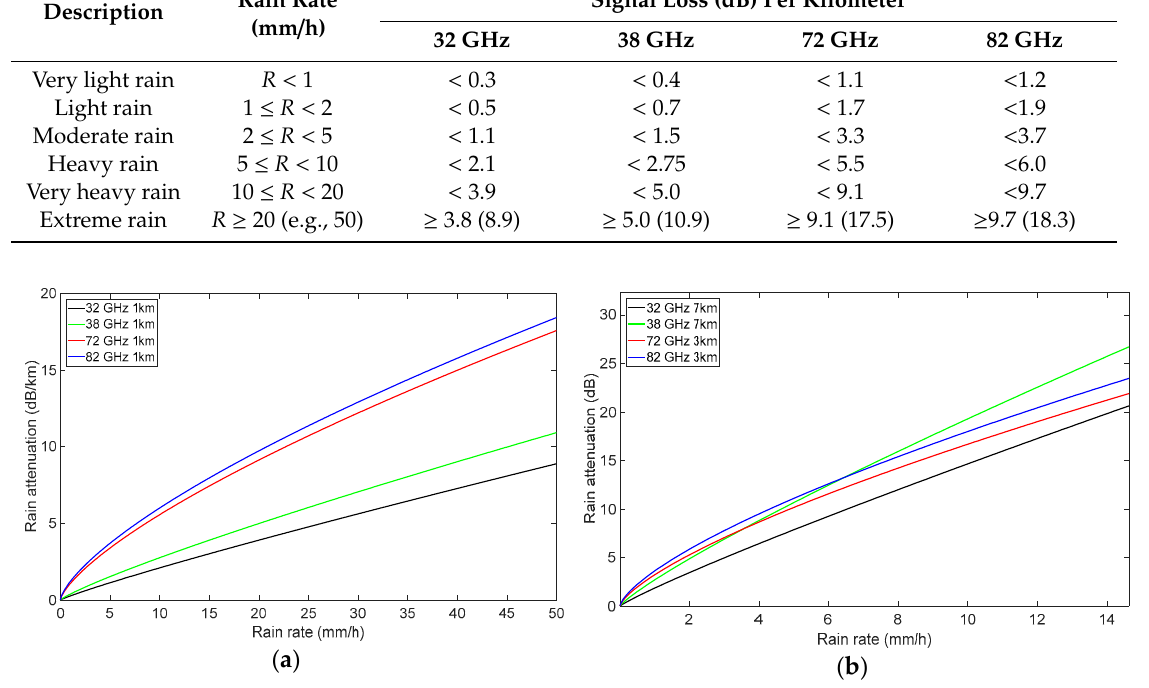
Figure 2. The theoretical rain-induced signal attenuation for various rain rates at di ff erent frequencies: ( a ) per kilometer; ( b ) over a 7-km long 32 GHz 2 × 2 line-of-sight multiple-input multiple-output (LOS-MIMO) link, a 7-km long single-input single-output (SISO) 38 GHz link, a 3-km long 72 GHz link, and a 3-km long 82 GHz test link using our measurement scenario.